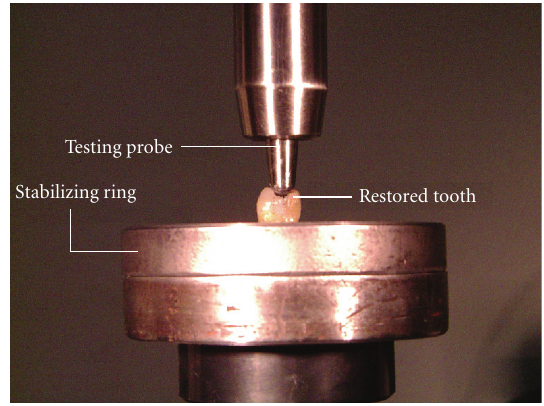
Figure 1: Photograph of restored tooth within compressive testing probe in contact with the cuspal